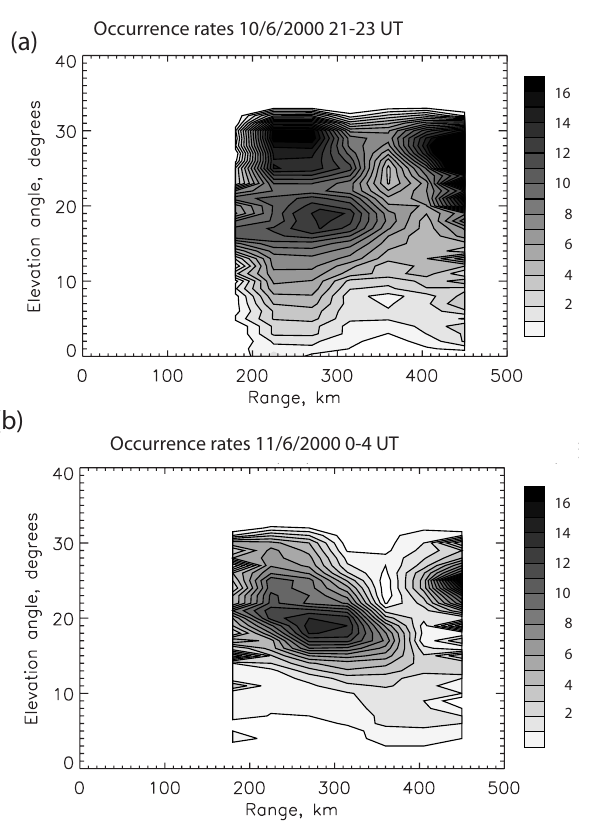
Fig. 6. Observed elevation angles, measured in degrees of near range echoes by the Hankasalmi HF radar (a) 21:00–23:00UT, 10 June 2000 (b) 00:00–04:00UT, 11 June 2000.